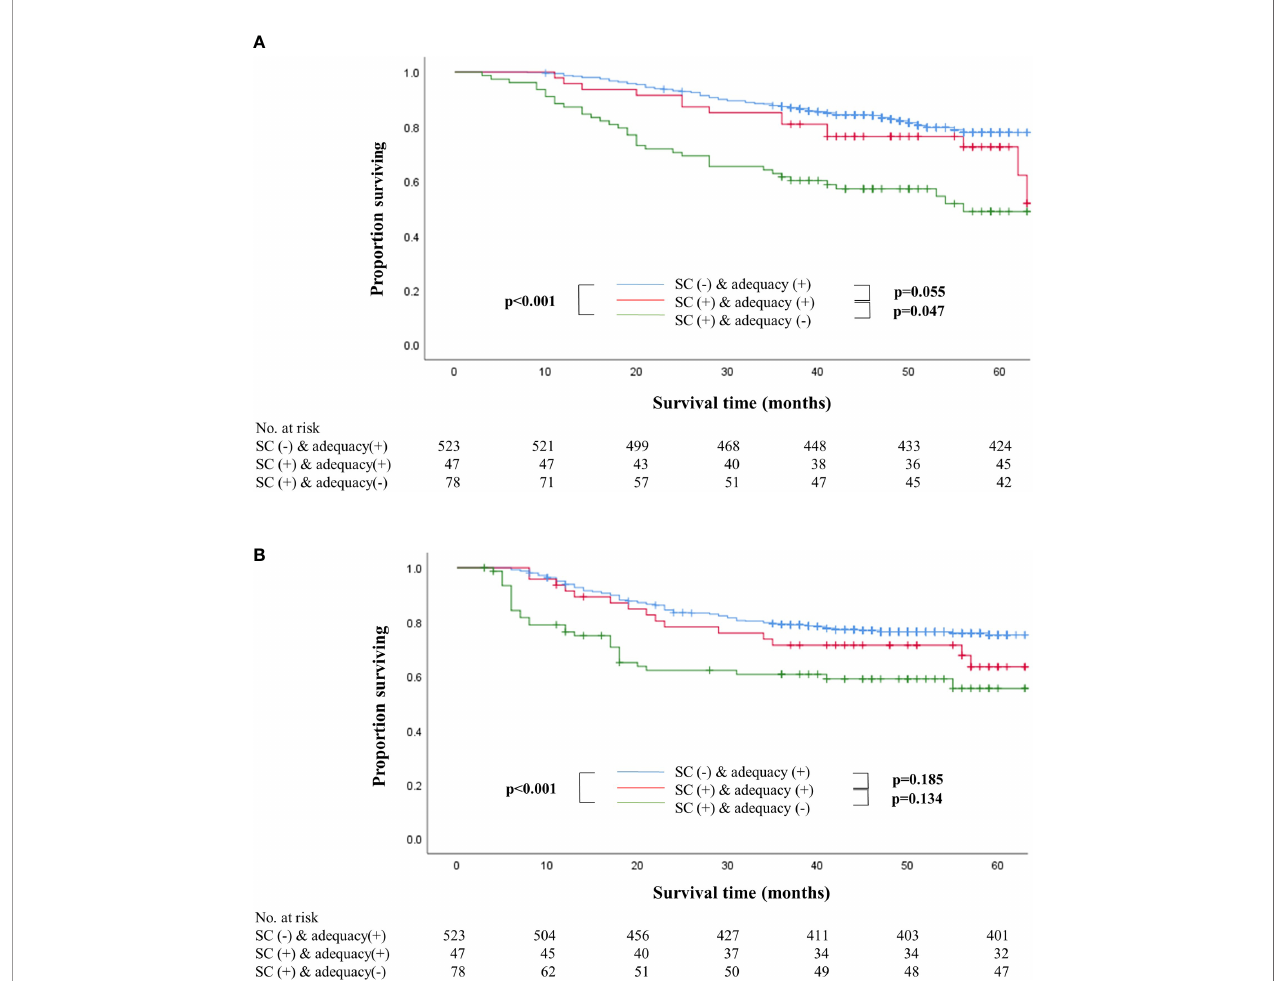
FIGURE 2 | Overall (A) and recurrence-free (B) survival according to the presence of serious complications with adequacy of adjuvant chemotherapy. (A) Overall survival according to the presence of serious complications with adequacy of adjuvant chemotherapy. (B) Recurrence-free survival according to the presence of serious complications with adequacy of adjuvant